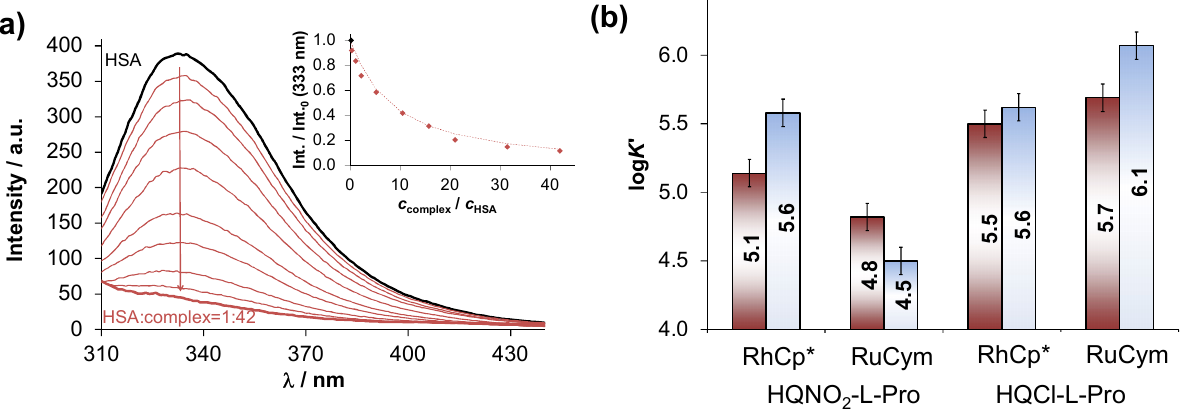
Figure 9. ( a ) Fluorescence emission spectra recorded for HSA upon addition of various amount of RhCp*–HQNO 2 -L-Pro complex using λ EX = 295 nm and 24 h incubation time. Inserted figure shows the intensity (Int.) changes at 333 nm plotted against c complex / c HSA ratio. ( b ) Quenching (log K Q ′, left red bars) and DG marker displacement (log K DG ′, right blue bar) constants of the complexes for their binding to HSA at site I and II, respectively, obtained from spectrofluorometric measurements. Data for HQCl-L-Pro complexes are taken from Ref. [12]. { c HSA = 1 µ M, c DG = 1 µ M, c complex = 0–42 µ M, λ EX = 295 nm (Trp-214) or λ EX = 335 nm (DG); pH = 7.4, (PBS’)}.